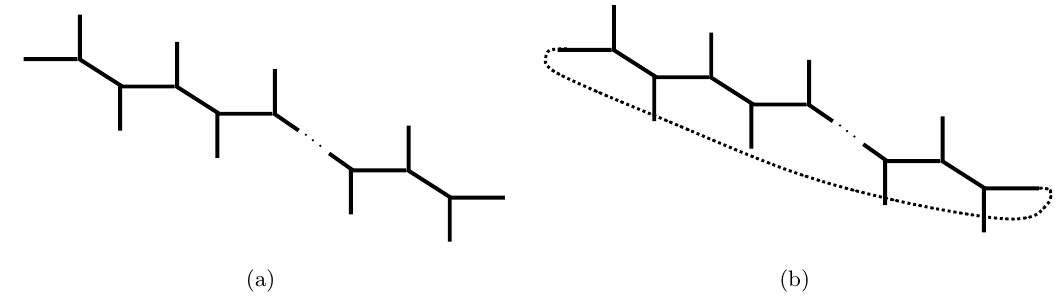
Figure 1 . The web diagram descriptions of the toric Calabi-Yau threefolds. The left (cid:12)gure (a) is the N -chain geometry which contains N vertical lines. The right (cid:12)gure (b) is the periodic N -chain geometry. The black dotted lines imply the